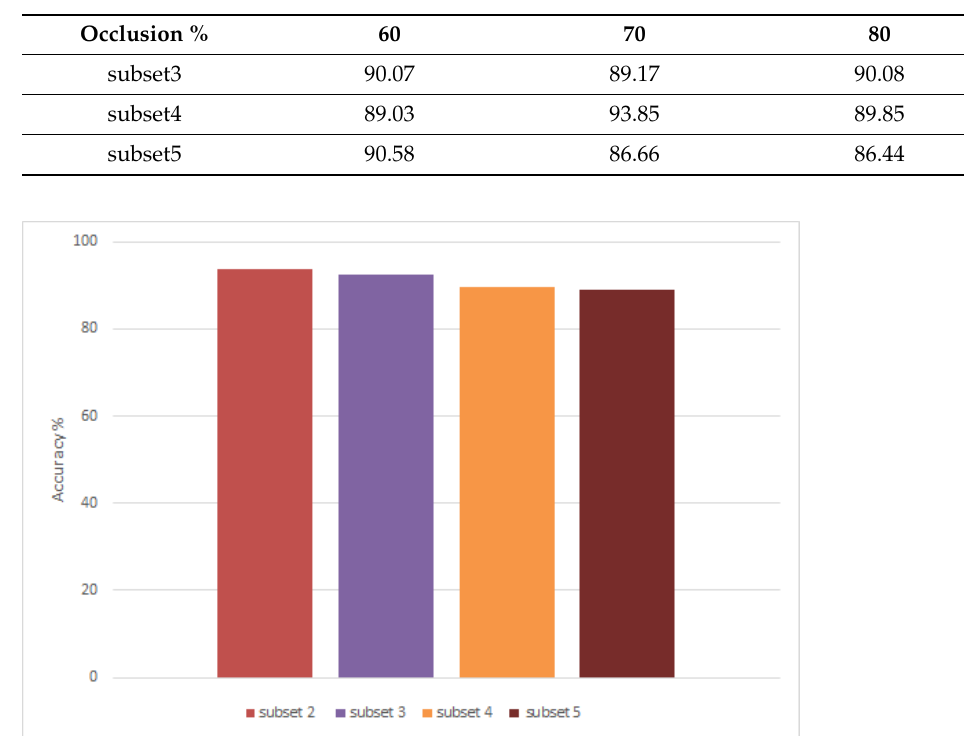
Figure 15. Results for each Extended Yale B dataset subset averaged over the different levels of